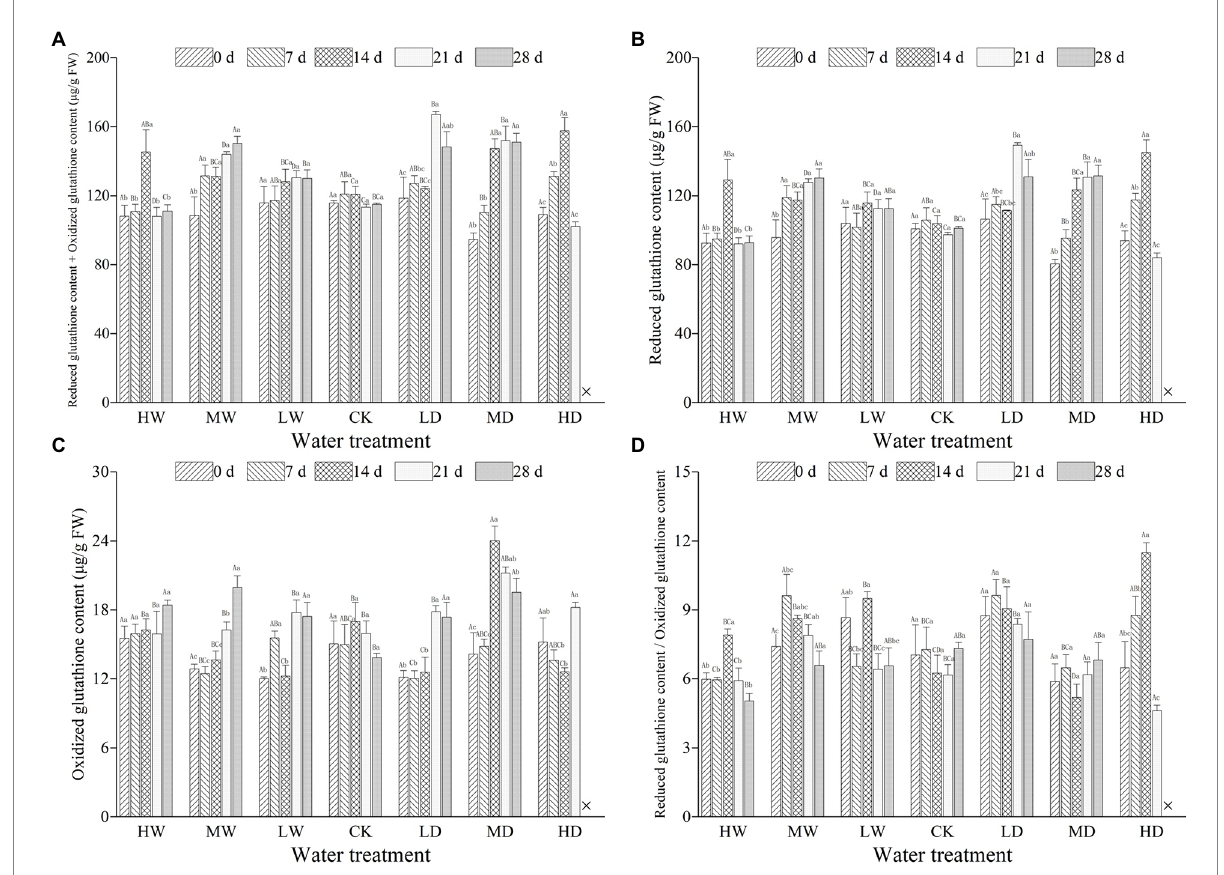
FIGURE 2 Total glutathione contents (A) , reduced glutathione (B) , oxidized glutathione (C) and ratio of reduced glutathione to oxidized glutathione (D) in leaves of hairgrass ( Deschampsia caespitosa ) under contrasting hydrological regimes and durations. Bar values are the mean ± standard error ( N = 3). Different lowercase letters indicate that there are significant differences among stress exposure durations under the same hydrological treatment; and different capital letters indicate that there are significant differences across different water hydrological regimes at the same exposure duration. X represents the plant died, and thus not allows this parameter to be determined unless stated otherwise. Water treatment are as follows: HW, Heavily waterlogging; MW, Moderate waterlogging; LW, Light waterlogging; CK, Control; LW, Light drought; MW, Moderate drought; and HW, Heavily drought.